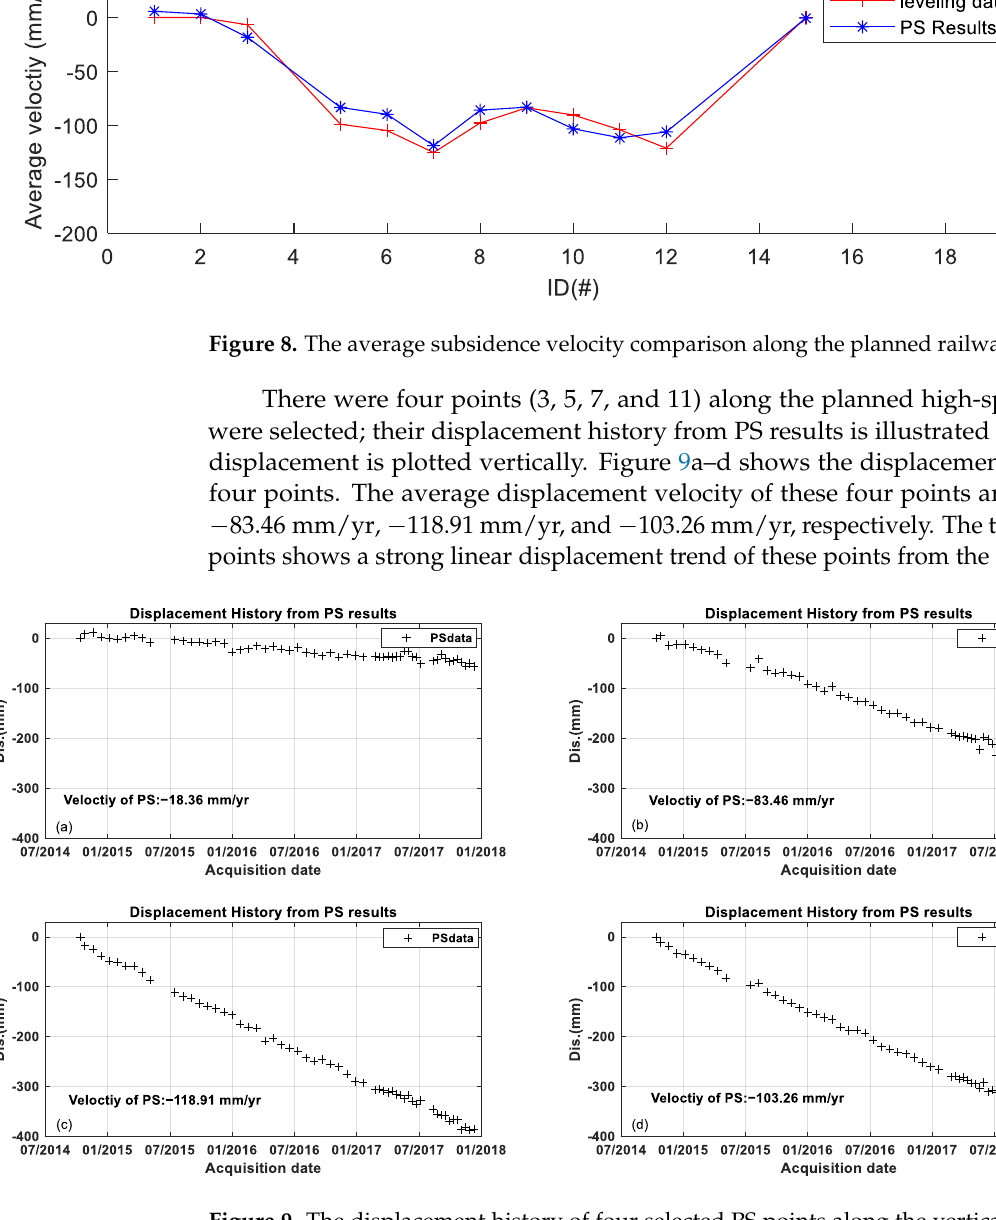
Figure 9. The displacement history of four selected PS points along the vertical direction from PS results along a planned high-speed railway. The black crosses represent the displacements history from PS results. ( a – d ) shows the extracted displacement history at the points of ID3, ID5, ID7, and ID11, respectively.